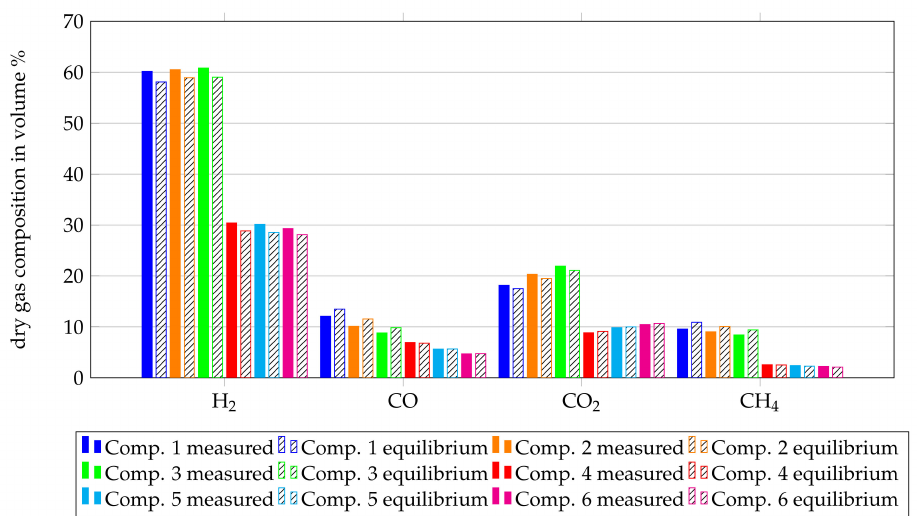
Figure 8. Comparison of the dry gas compositions after the reformer with the equilibrium gas compositions at the average temperature of the reaction